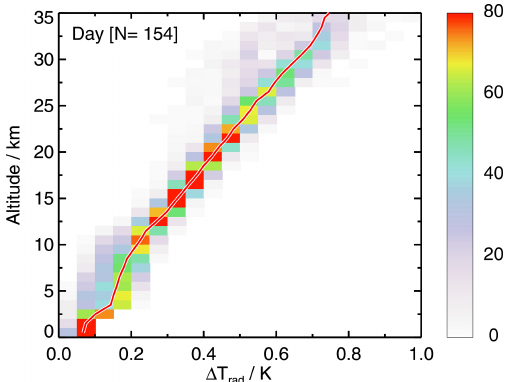
Figure 19. Scatter density plot of the estimated radiation tempera- ture error (cid:49)T rad for 154 daytime radiosounding profiles performed in Lindenberg between 2014 and 2021. The colour represents the number of data points in 0.05K × 1km wide bins, and the red line denotes the median of the bias in each